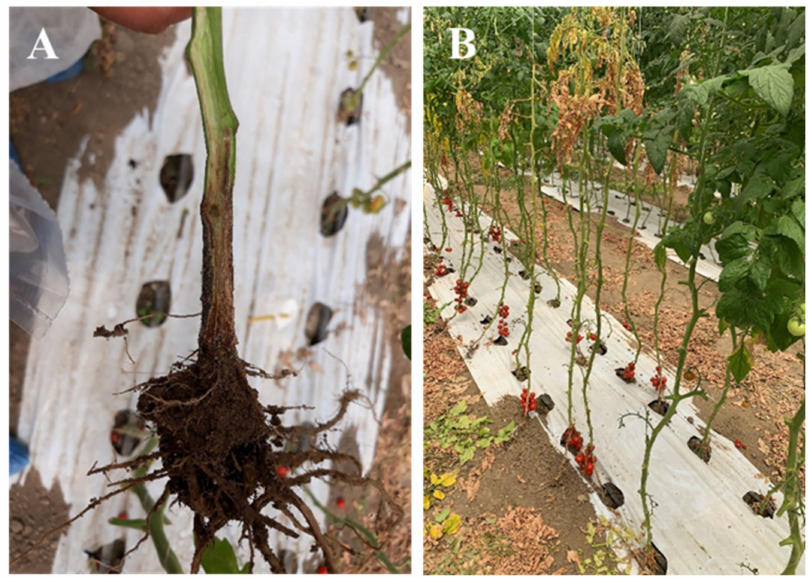
Figure 4. Fusarium wilt caused by Fusarium oxysporum f. sp. lycopersici causing typical dark brown colour on plant vessels ( A ), leading to plant collapse ( B